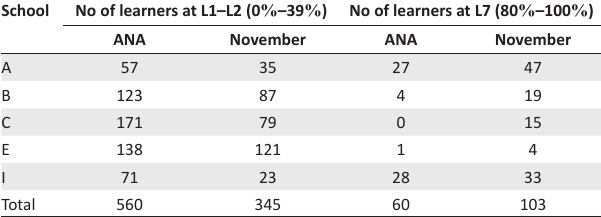
TABLE 3: Differences in frequencies of learner performance for the two